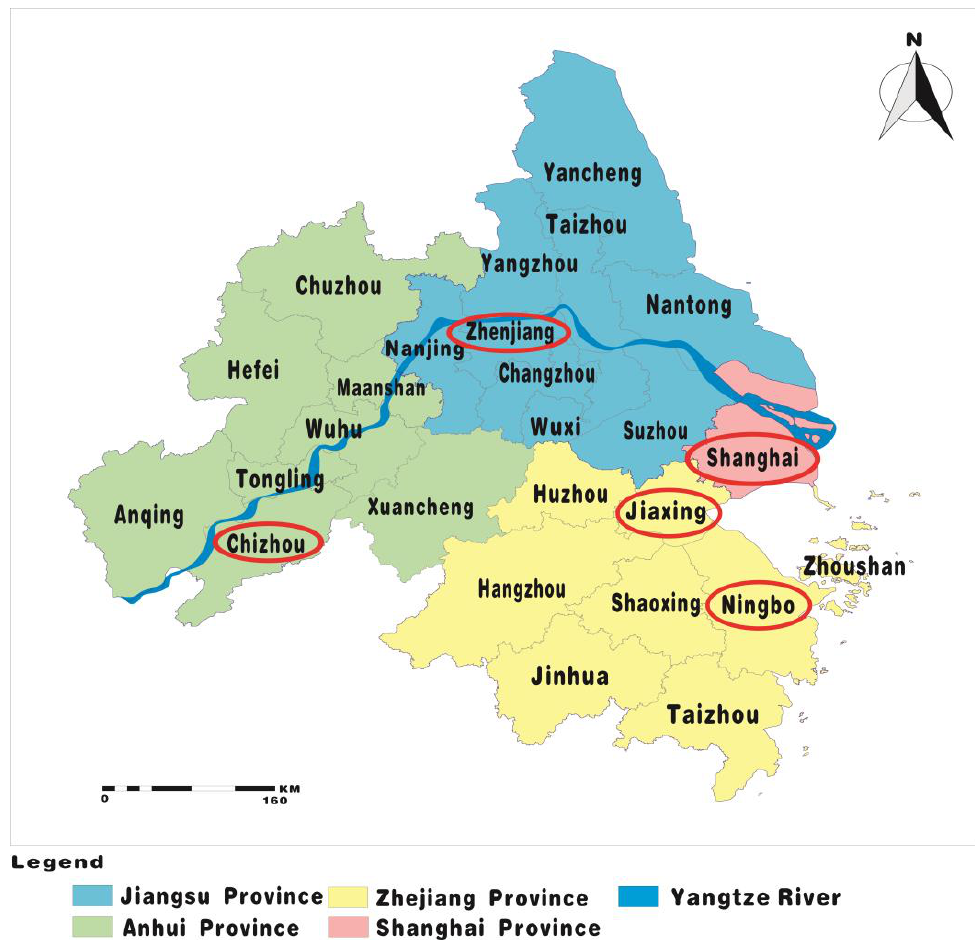
Figure 2. The location of the surveyed cities in the Yangtze River Delta Region. Note: The red circles highlight the location of the surveyed cities.